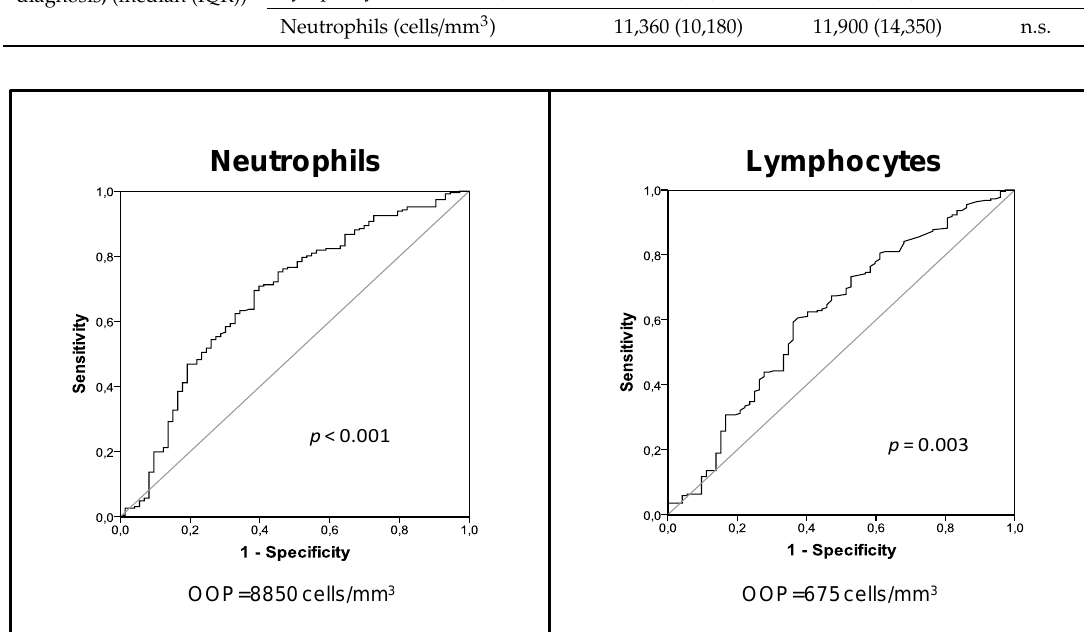
Figure 1. AUROC analysis for ICU mortality in sCAP patients with septic shock. Table 2. Logistic regression analysis for predicting ICU mortality in the sCAP group with septic shock: neutrophil count.